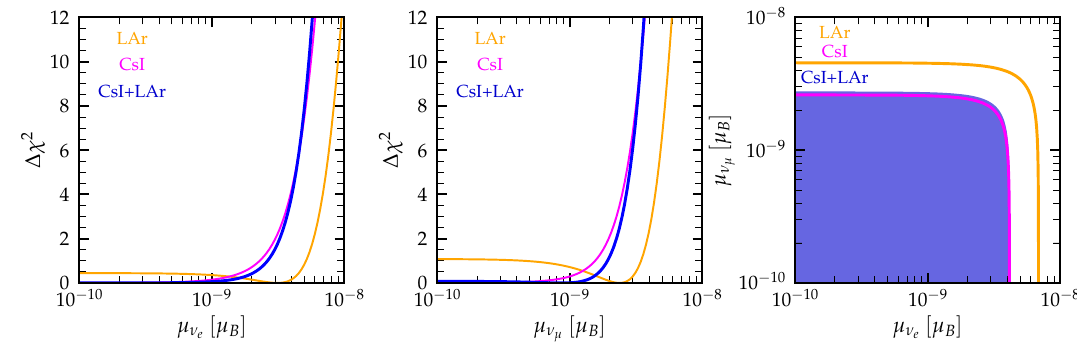
Figure 11 . Left and middle panels: ∆ χ 2 profile for the effective neutrino magnetic moments µ ν and µ obtained from the analysis of CsI (magenta), LAr (orange) and CsI + LAr (blue) data. ν µ Right panel: 90% C.L. allowed regions (2 d.o.f.) when two effective MM are taken simultaneously. The analysis of CsI data includes CE ν NS + ES